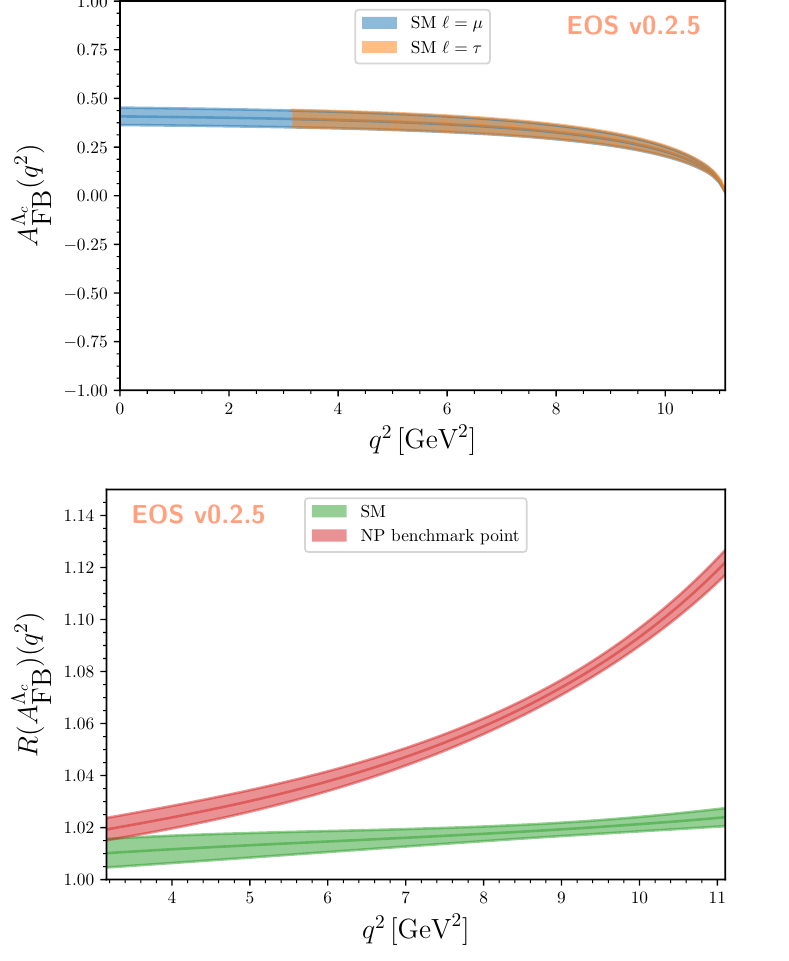
Figure 1 . Predictions for (top) the hadronic forward-backward asymmetry in the SM for ‘ = (cid:22) and ‘ = (cid:28) (cid:12)nal states, and (bottom) the LFU ratio R ( A (cid:3) c ) in the SM and in the NP benchmark point FB BMP #1. The bands correspond to the 68% probability envelopes. The theoretical uncertainties are due to the hadronic form factors [50] and the parity violating parameter (cid:11) (see text). Due to the absence of any threshold e(cid:11)ects with respect to the dilepton mass, the two bands for the hadronic forward-backward asymmetry are virtually indistinguishable. The LFU ratio hence exhibits this large sensitivity to the NP benchmark